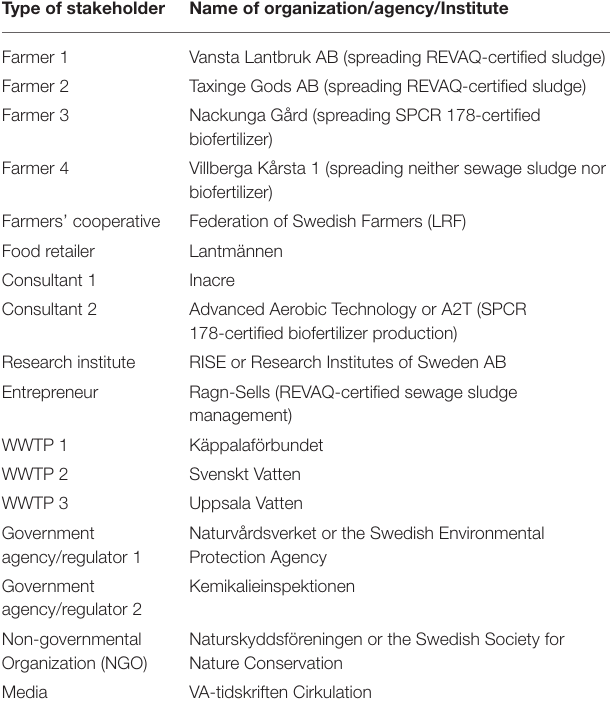
Type of stakeholder Name of